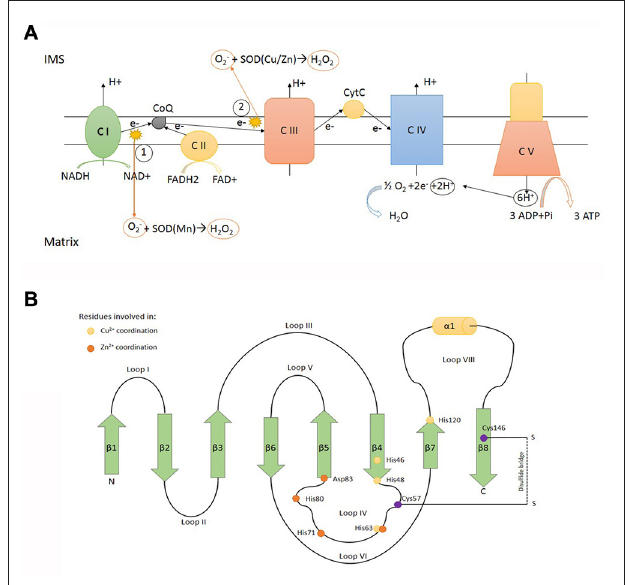
FIGURE 1 | SOD1 function and structure. (A) Electron transport chain locatedin the inner mitochondrial membrane (IMM). (1) and (2) represent the main sources of superoxide anion (O 2 − ), a reactive oxygen specie converted to H 2 O 2 in a dismutase reaction catalyzed by SOD (Cu/Zn; SOD1) and SOD (Mn; SOD2) in the intermembrane mitochondrial space (IMS) and matrix, respectively. C I: complex I NADH dehydrogenase. C II: complex II succinate dehydrogenase. C III: complex III ubiquinol cytochrome C oxidoreductase. C IV: complex IV cytochrome C oxidase. C V: complex V ATP synthase. (B) Scheme representing the determinants of tertiary structure of human SOD1, including β sheets (green arrows), α helix (yellow cilinder) and loops. β sheets: β 1: 2–8 ◦ aa - β 2: 15–22 ◦ aa - β 3: 29–36 ◦ aa - β 4: 41–48 ◦ aa - β 5: 83–89 ◦ aa - β 6: 95–101 ◦ aa - β 7: 116–120 ◦ aa - β 8: 143–151 ◦ aa. α helix: 134–137 ◦ aa. The yellow dots represent residues involved in Cu 2 + coordination (His46, His48, His63, His120). The orange dots represent residues involved in Zn 2 + coordination (His63, His71, His80, Asp83). The purple dots represent residues involved in disulfide bridge formation (Cys57,